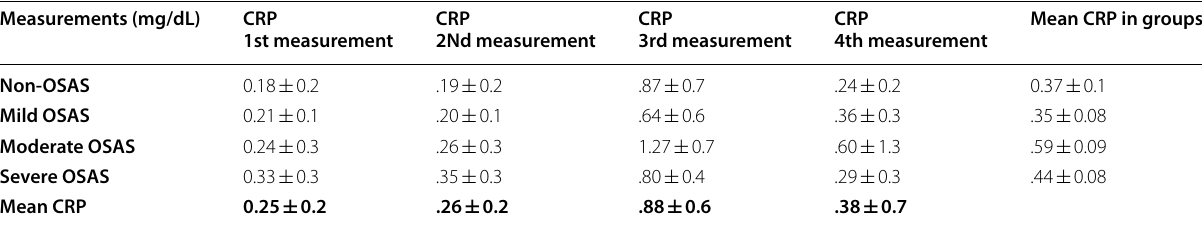
Table 4 Comparison of CRP levels between the groups